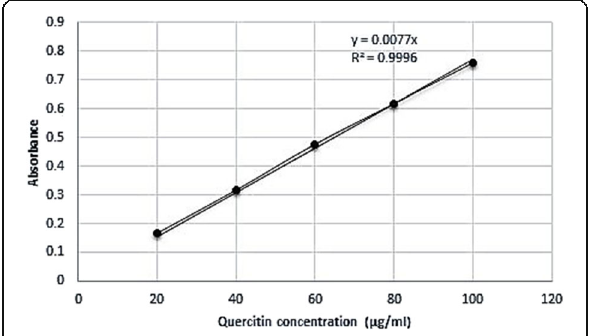
Fig. 1 Calibration curve of quercetin